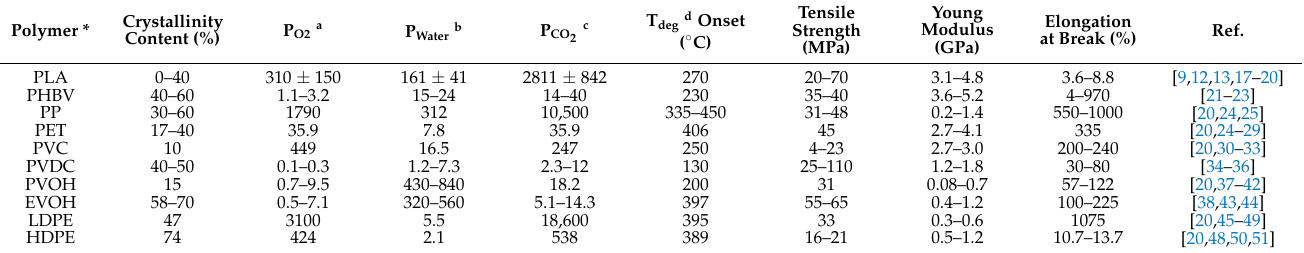
Table 1. Comparison of the main barrier (permeability coefficient for O 2 , water, and CO 2 in Kg · m · m − 2 · s − 1 · Pa − 1 ) and the thermal and mechanical properties of polymers used in food